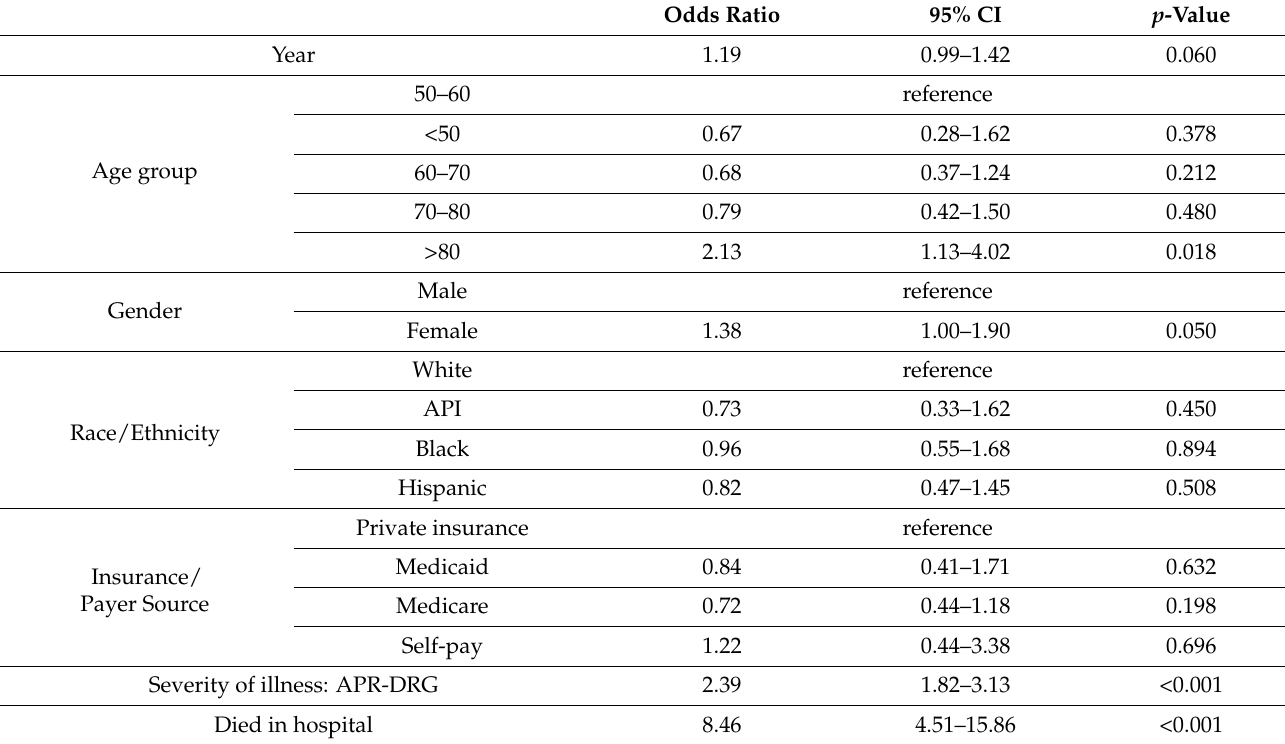
Table 2. Factors associated with receipt of inpatient palliative care services in ECC in US hospitals. NIS Data (2007–2016).